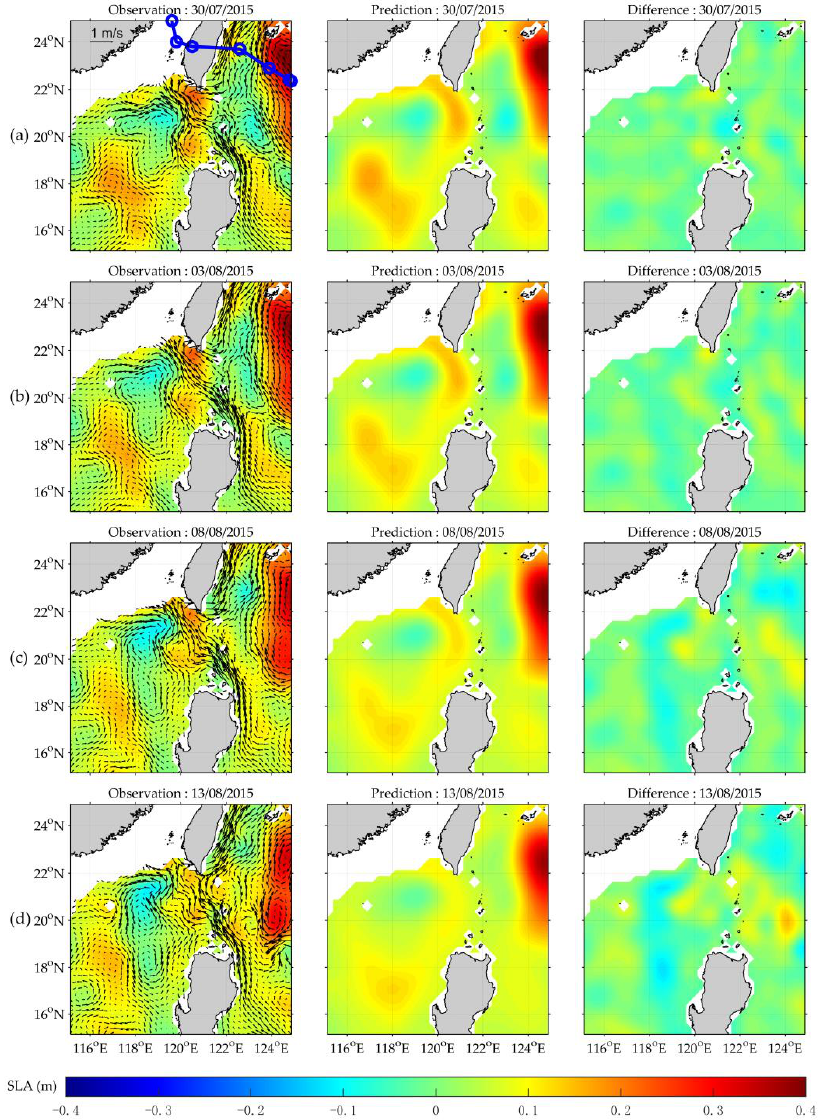
Figure 15. Comparison between observed and predicted SLA at ( a ) day 1, ( b ) day 5, ( c ) day 10, ( d ) day 15. The left column shows the results from observation, the middle column shows the results from the prediction, and the right column shows the difference between the observed and predicted SLA . Black vectors are the variation of geostrophic current. Blue line is track of Typhoon Soudelor from 30 July 2015 to 13 August 2015.